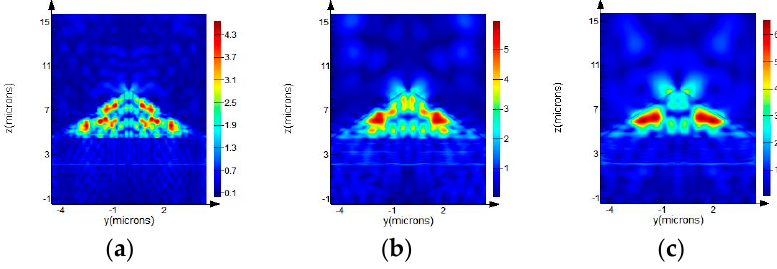
Figure 2. Photon absorption profile at cross section at ( a ) 800 nm; ( b ) 1500 nm; and ( c ) 2100 nm wavelength.